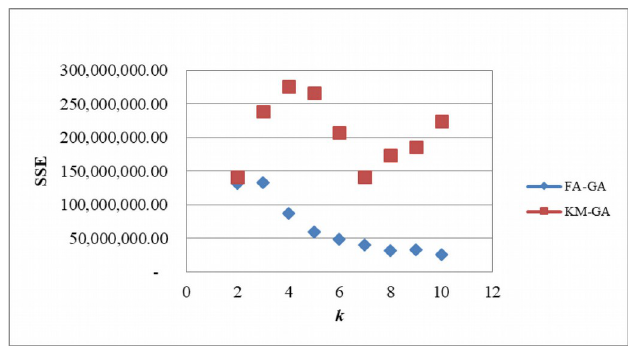
Figure A-1. Sum of the squared error vs. k values for instance KorA200